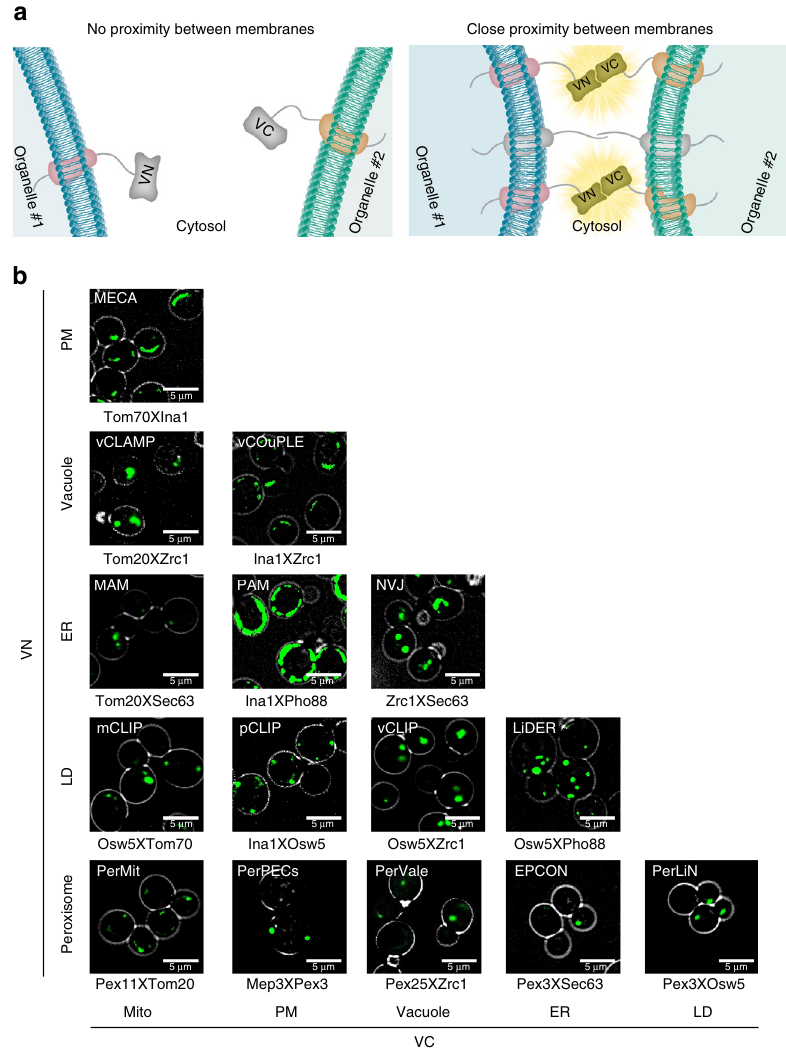
Fig. 1 A Split Venus reporter uncovers four potential new contact sites. a A schematic diagram of the split Venus contact site reporter. We fused half of a Venus fl uorescent protein (VN) to a membrane protein localized to one organelle and the other half of the Venus protein (VC) to a membrane protein localized to a second organelle. Only when the two organelles come into close proximity, such as that which occurs at a contact site, a fl uorescent signal is emitted. b Pairwise combinations between membrane proteins tagged with half of the Venus protein were used to detect the proximity between cellular compartments (mitochondria — Mito, plasma membrane — PM, vacuole, endoplasmic reticulum — ER, lipid droplets — LD and peroxisomes). The names of previously identi fi ed contacts are written in white. The pattern and abundance of the different reporters is variable. This systematic analysis shows that every two cellular compartments that were examined can be juxtaposed suggesting four new contact sites. We suggest naming the new contacts (in bold white): vCOuPLE (vacuole-plasma membrane contact); pCLIP (for plasma membrane contact with lipid droplets); PerPECs (for peroxisome plasma membrane contact site), and PerVale (for peroxisome vacuole